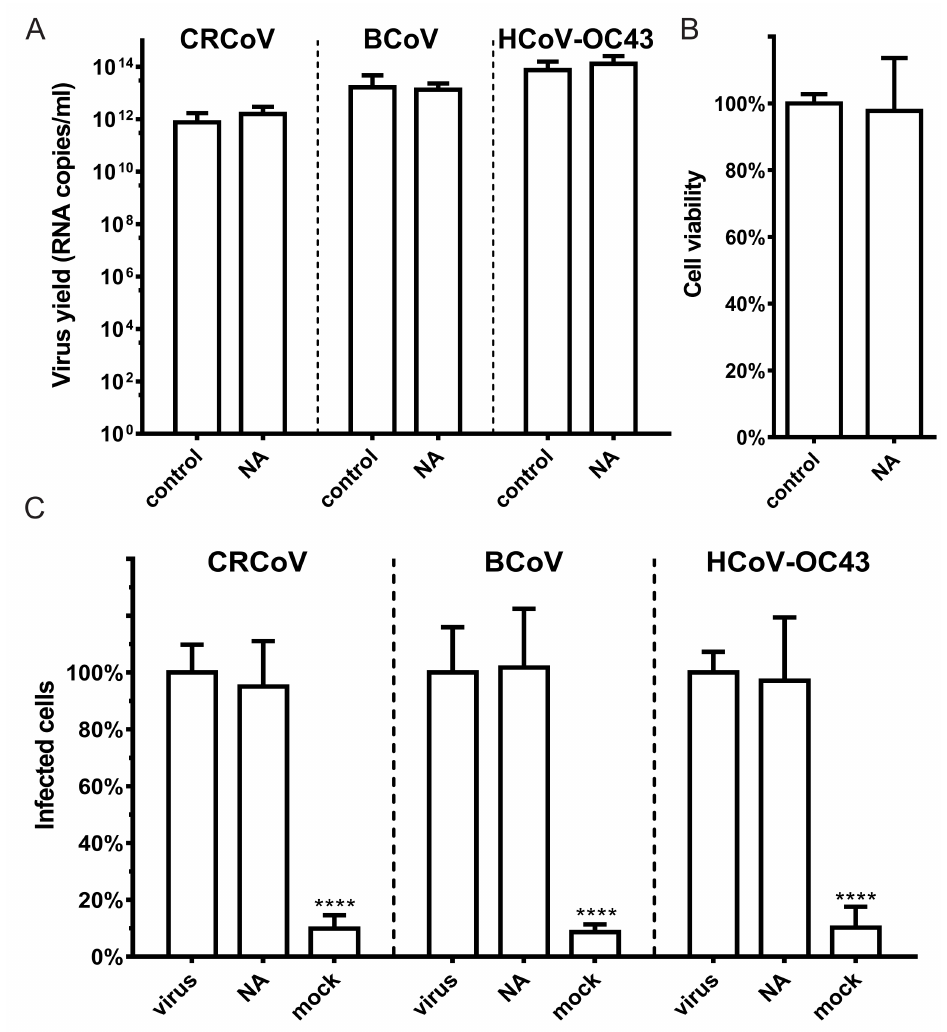
Figure 4. SAs removal does not affect HCoV-OC43 VR-1558, BCoV, or CRCoV replication. Cells pretreated with type II neuraminidase (NA, 200 mU/mL) were overlaid with HCoV-OC43 VR-1558, BCoV and CRCoV stocks (at TCID 50 of 400 per milliliter, which approximately corresponds to M.O.I. = 0.0007) and incubated for 2 h at optimal temperature (see Viral stocks ). Subsequently unbound virions were washed off and the cells were further incubated at optimal temperature for five